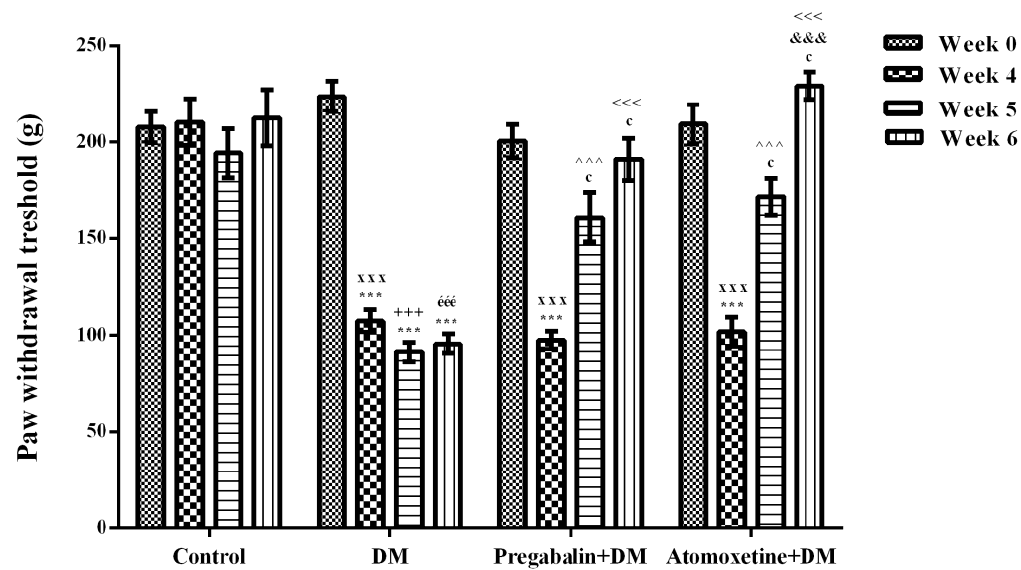
Figure 1. Paw withdrawal thresholds of normoglycemic rats administrated physiological saline (Control), and of diabetic rats administrated daily 10 mg/kg pregabalin (Pregabalin + DM) and daily 3 mg/kg atomoxetine (Atomoxetine + DM), in the Randall-Selitto test. Values are given as mean ± S.E.M. Within the groups: significant difference against Week 0, Week 4 and Week 5 groups are *** p < 0.001; c p < 0.001 and &&& p < 0.001, respectively. Between the groups: significant difference against Week 4 control, Week 5 control, Week 6 control, Week 5 DM and Week 6 DM groups are xxx p < 0.001; +++ p < 0.001, ééé p < 0.001, ˆˆˆ p < 0.001 and <<< p < 0.001, respectively. Two-way repeated ANOVA, post hoc Bonferroni test, n = 8.